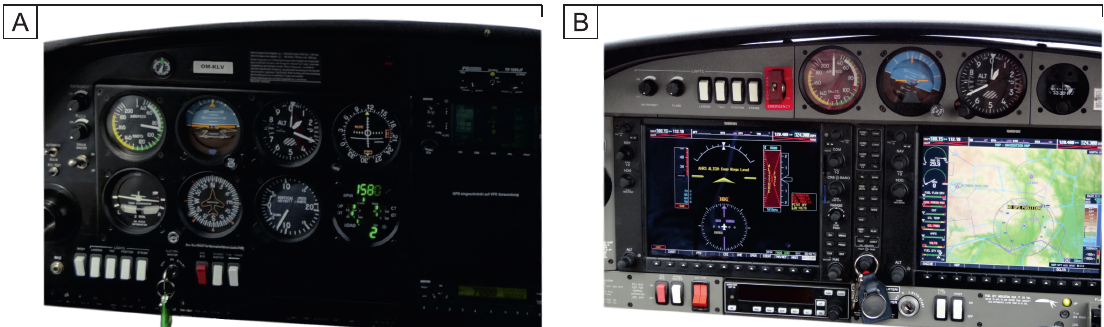
Figure 1. Presentation of analogue cockpit ( A ) and glass-cockpit ( B ) in Diamond Star